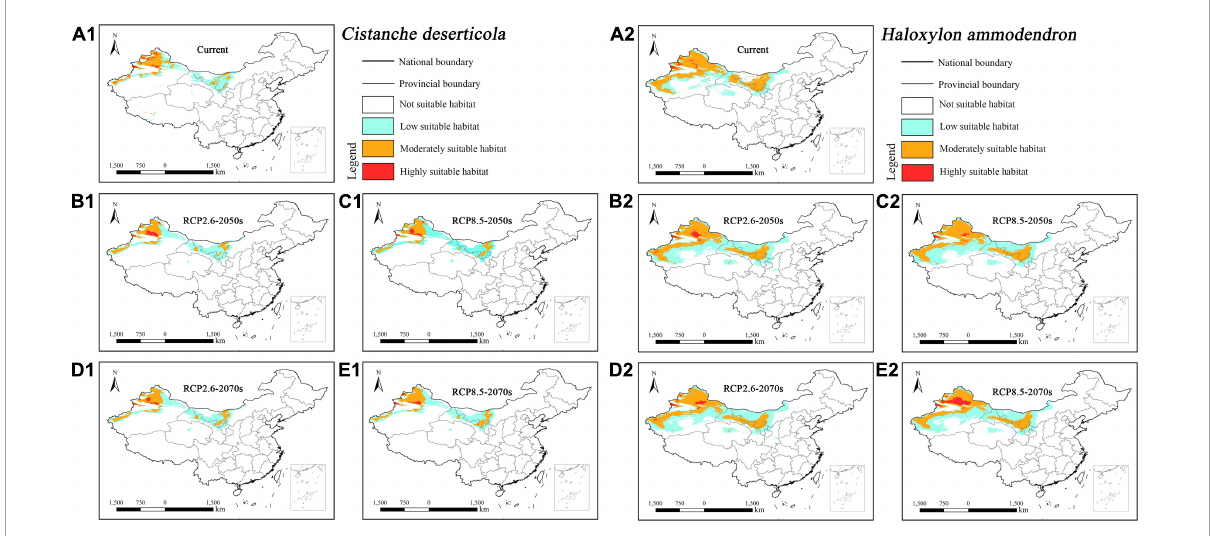
FIGURE5 Predicted suitable habitat distributions of Cistanche deserticola (A1–E1) and its host Haloxylon ammodendron (A2–E2) under different climate scenarios in China.